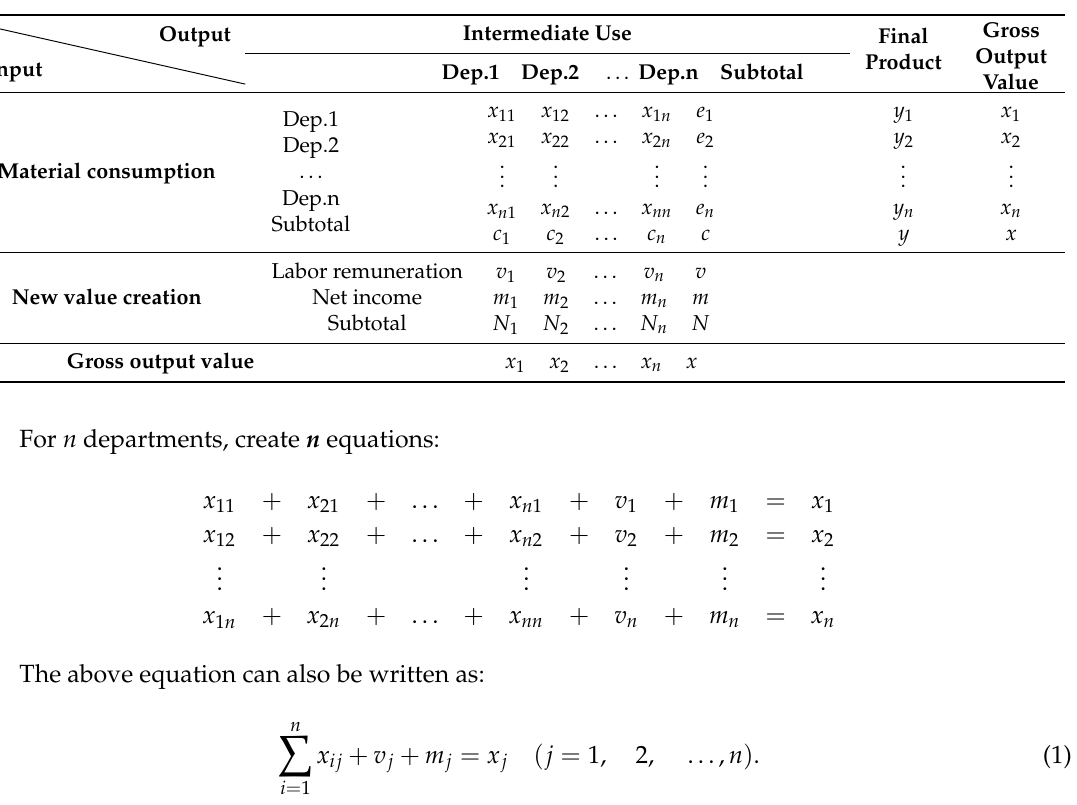
Table 2. Value input and output